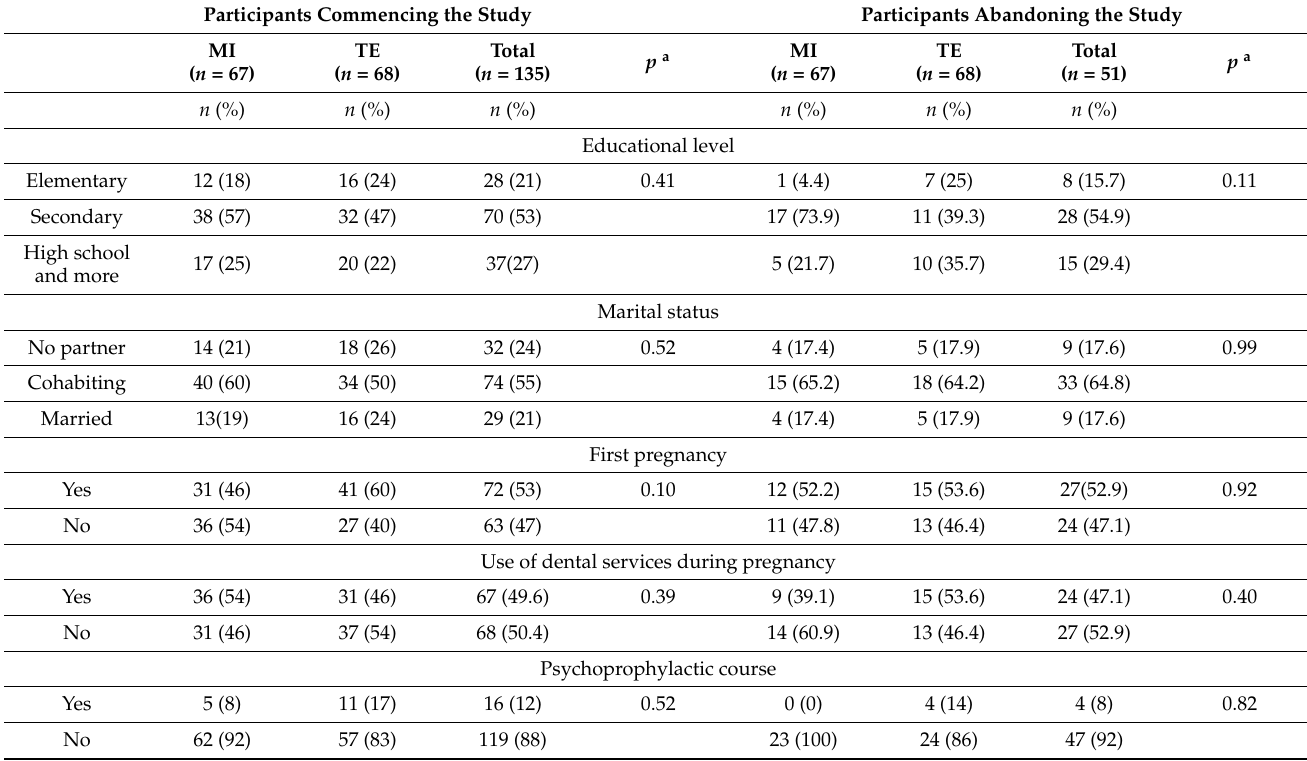
Table 1. Sociodemographic profiles and use of dental services by the expectant mothers commencing and abandoning the study. Leon, Guanajuato, Mexico,